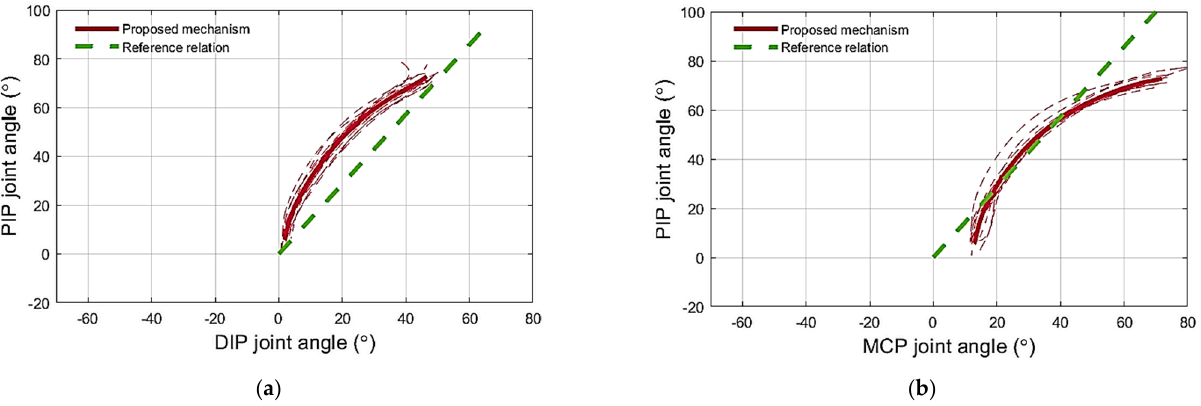
Figure 9. ( a ) PIP–DIP joint angle relation obtained when extending the stiff artificial finger, simulating spasticity, using the proposed extension mechanism. ( b ) PIP–MCP joint angle relation obtained when extending the stiff artificial finger, simulating spasticity, using the proposed extension mechanism. The PIP–DIP and PIP–MCP reference relations reported in the literature [29,39] for the human finger are shown as green dashed lines.